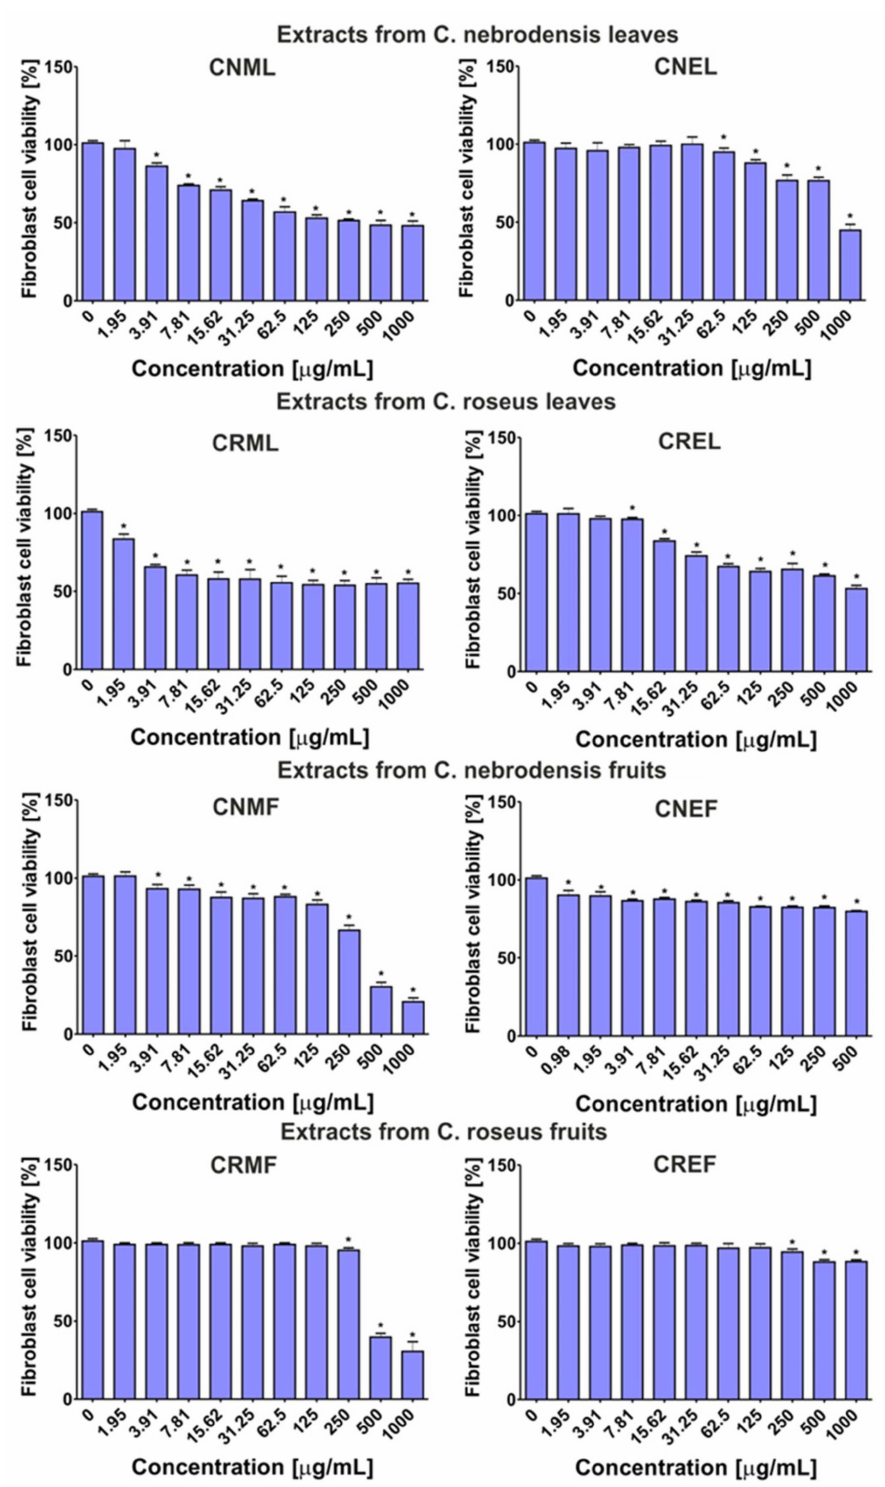
Figure 6. Viability of human normal fibroblasts (BJ cell line, ATCC CRL-2522 TM ) after 24-h treatment with serial dilutions of the extracts obtained from the leaves and fruits of C. nebrodensis (CNML, CNEL and CNMF, CNEF) and C. roseus (CRML, CREL and CRMF, CREF). The cell viability was evaluated using a MTT assay. * Significantly different data ( p < 0.05, unpaired t -test) compared to control, i.e., culture medium without substances—0 µ g/mL. The CNEF extract was evaluated at the concentrations of 500–0.98 µ g/mL due to its low